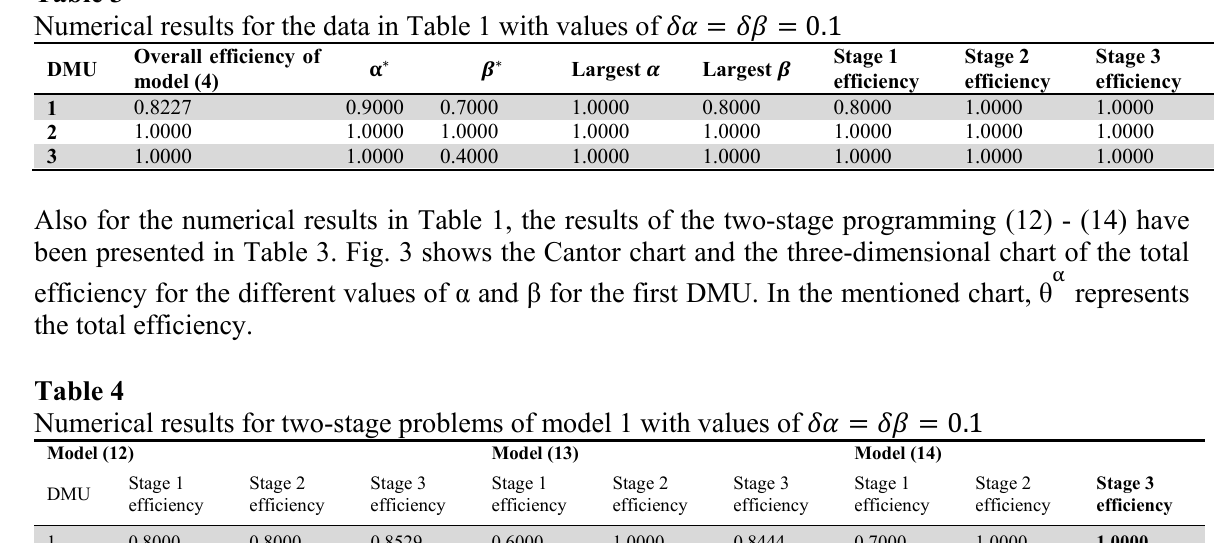
Model (14) Model (13) Model (12)